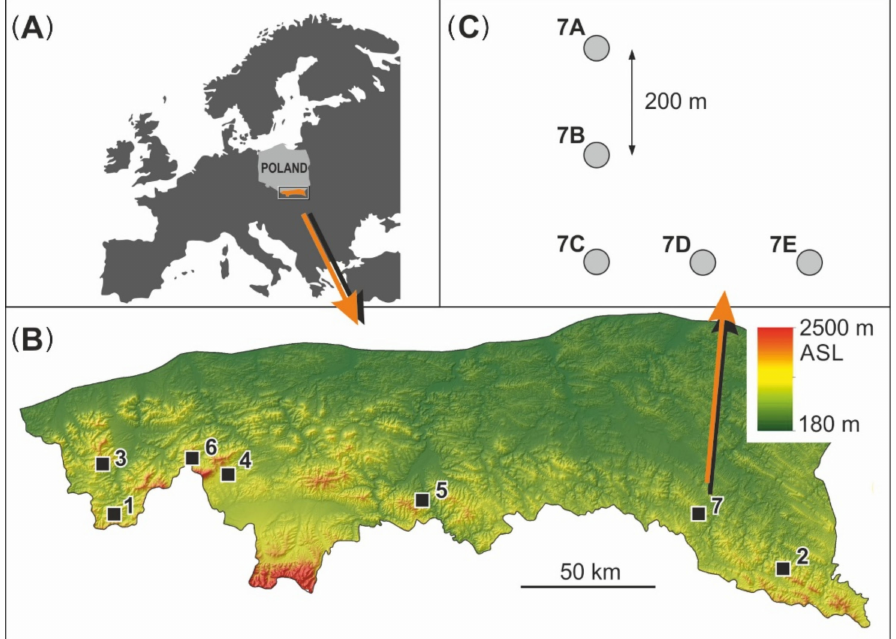
Figure 1. Study area on a map of Europe ( A ), distribution of study sites ( B ) (numbers), and distribu- tion of study plots (numbers with letters, e.g., 6A, 6B) at each study site ( C